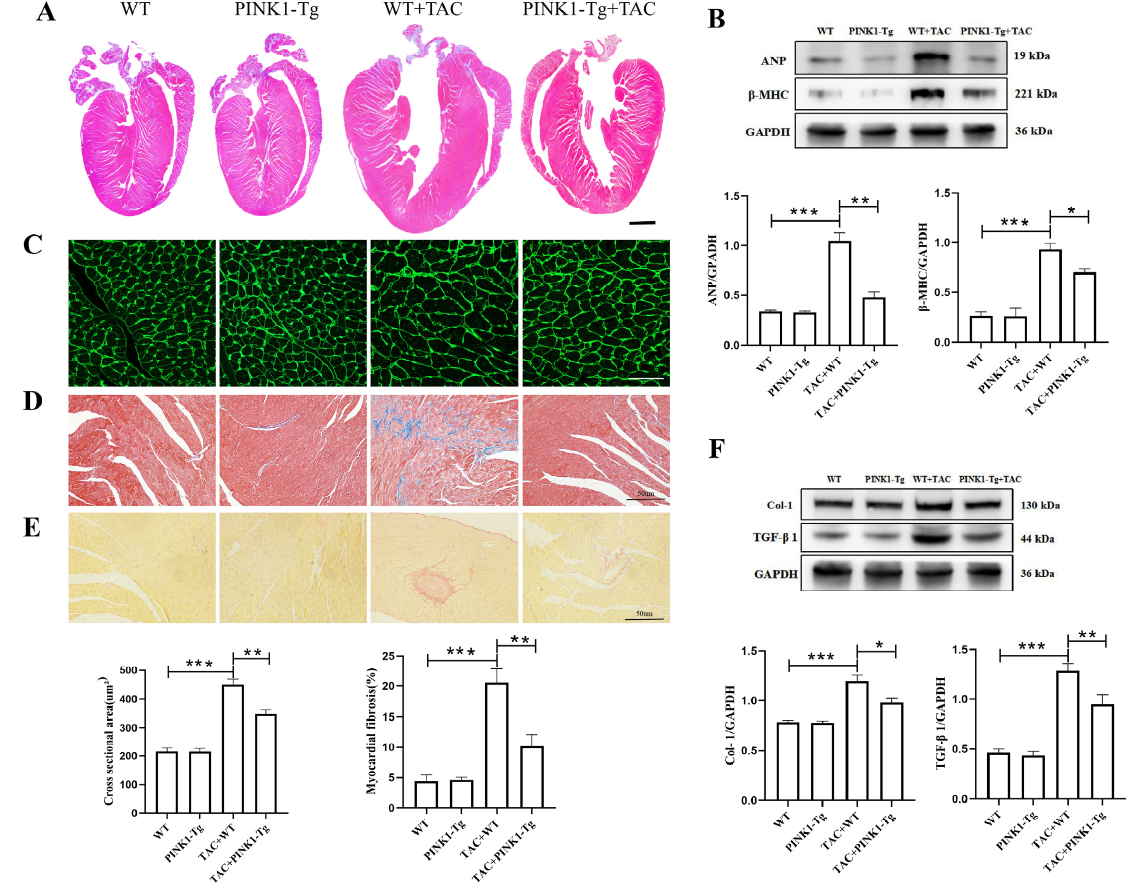
Figure 2. Cardiac-specific overexpression of PINK1 alleviated myocardial hypertrophy and fibrosis induced by transverse aortic constriction (TAC). Cardiac hypertrophy reflected by ( A ) HE staining in global and ( B ) protein expression of ANP and β -MHC (n = 3), and ( C ) WGA staining (n = 6). Collagen quantification was measured on Masson staining ( D ), Sirius Red staining ( E ) in detail (n = 6), and ( F ) protein (n = 3) expression of collagen 1 and TGF- β 1; statistical analyses ( A – F ) were per- formed by one-way ANOVAs followed by Bonferroni test post-hoc tests. *: p < 0.05, **: p < 0.01, ***: p < 0.001. Data are presented as the mean ± SD.